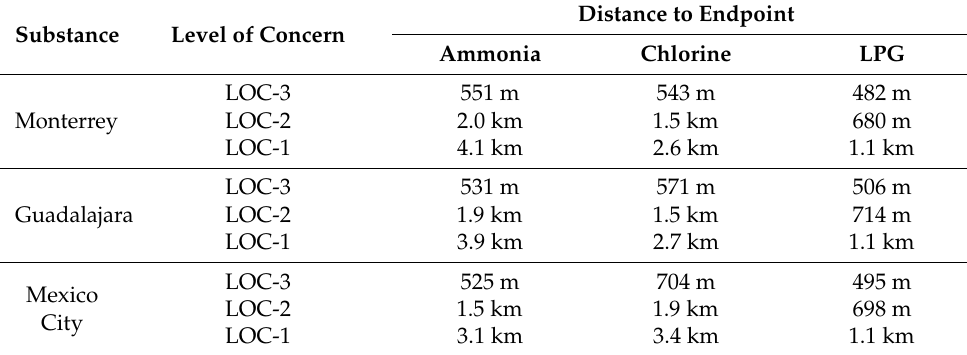
Table 3. Distance to endpoint of modeled